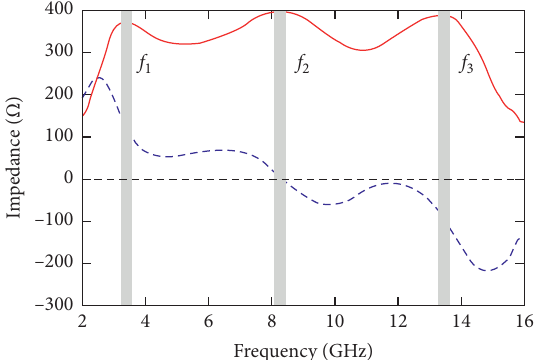
Figure 3: Input impedance of the proposed absorber.